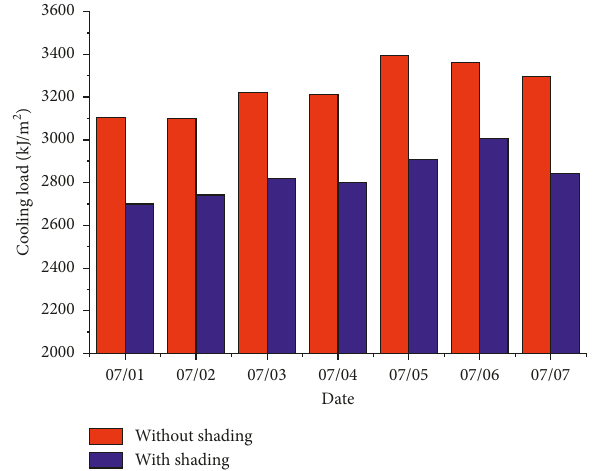
Figure 18: Temperature comparison with and without shading/air filtration mode (source: authors’ own